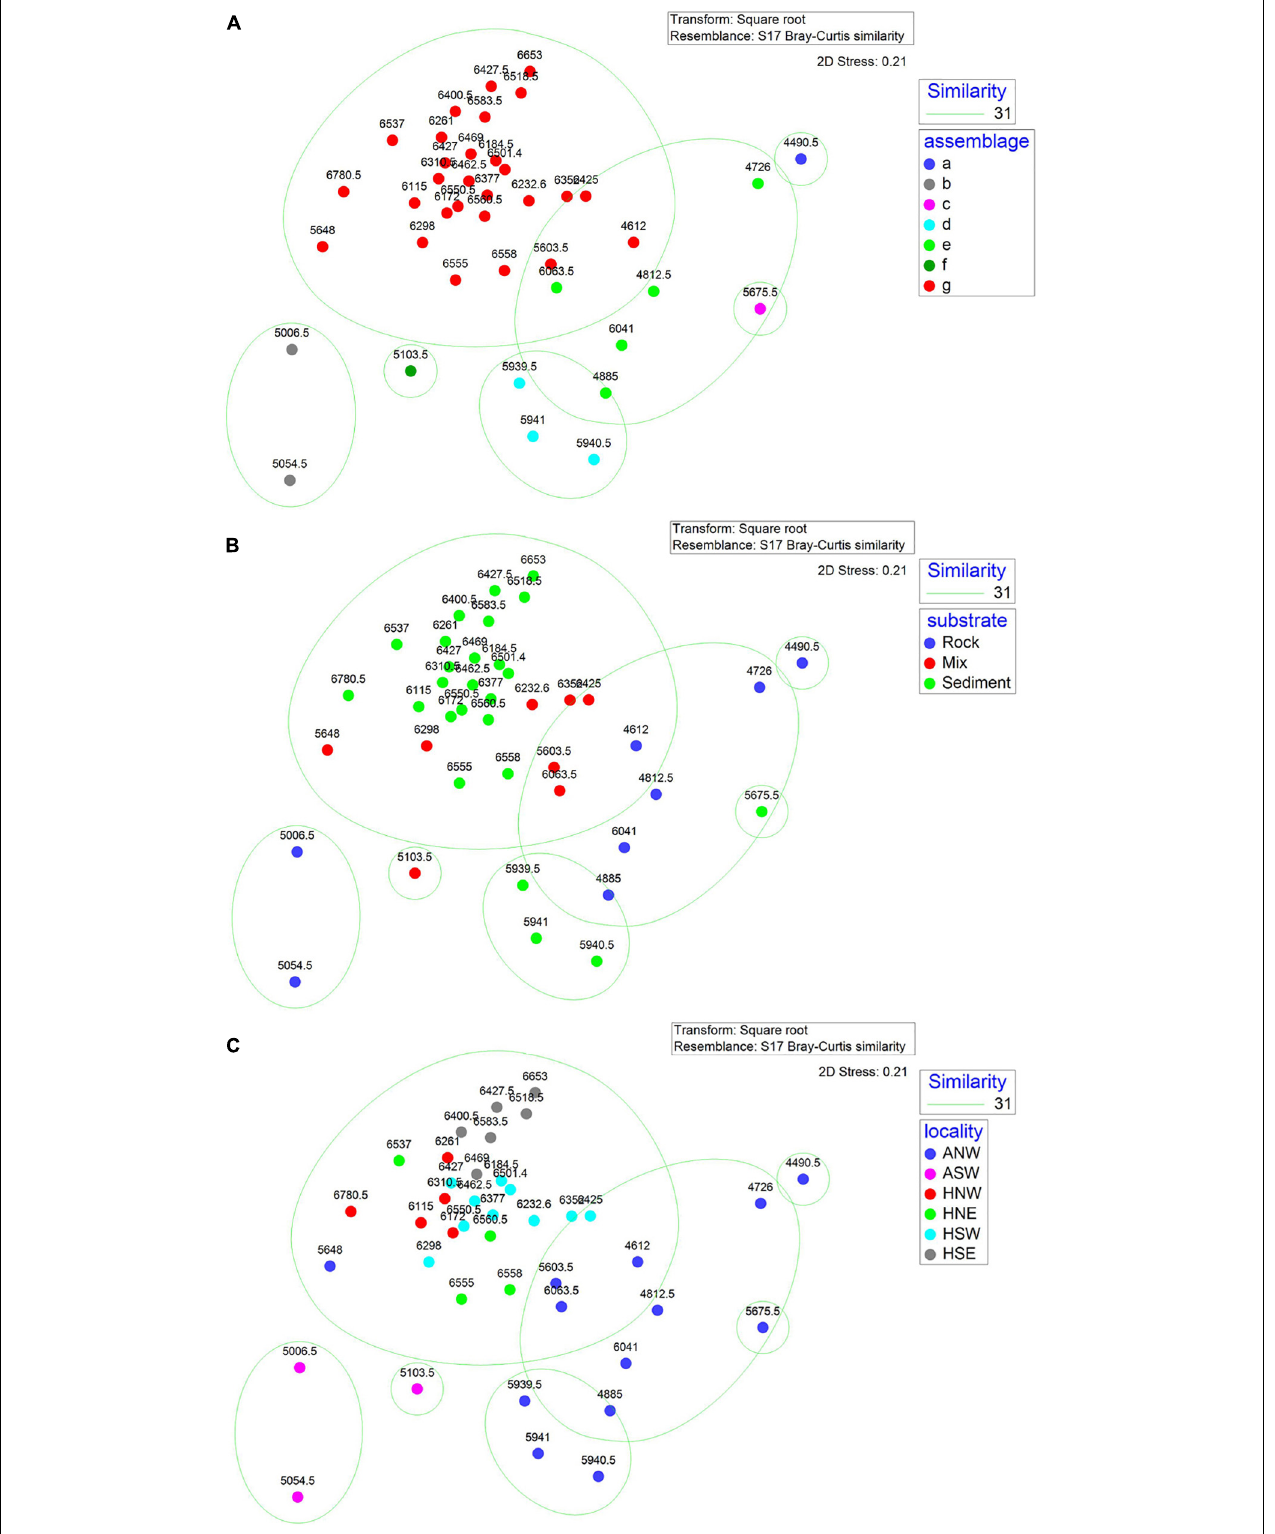
FIGURE 6 | Non-metric multi-dimensional scaling (nMDS) plots of sampling units labeled by (A) assemblages from cluster and SIMPROF; (B) substrate type; (C) geographic position. Numbers on the dots indicate the water depth of each segment.